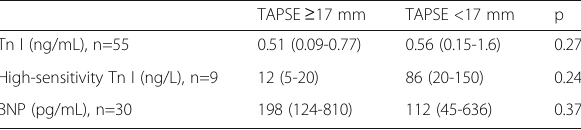
Table 1 (abstract 000018). Relationship between RV systolic function assessed by TTE and cardiac biomarkers